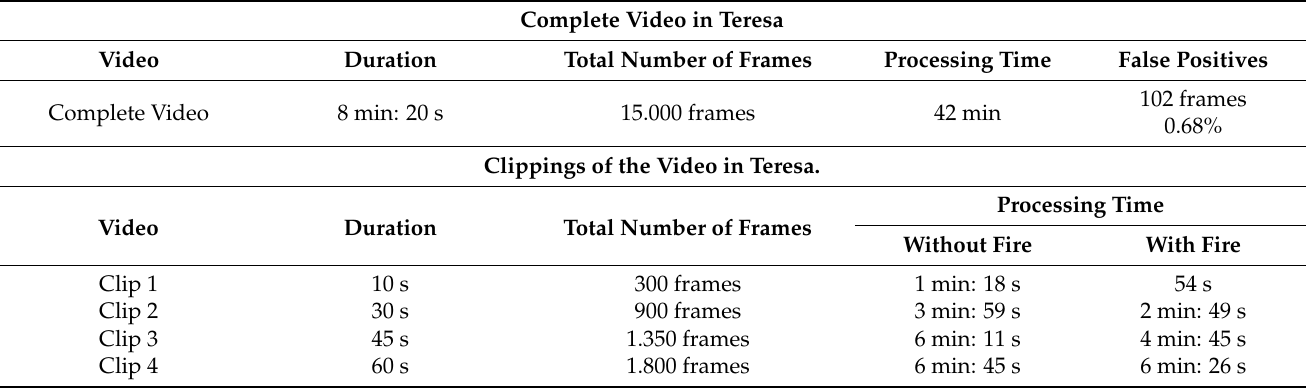
Table 5. Vision algorithm results for fire detection.